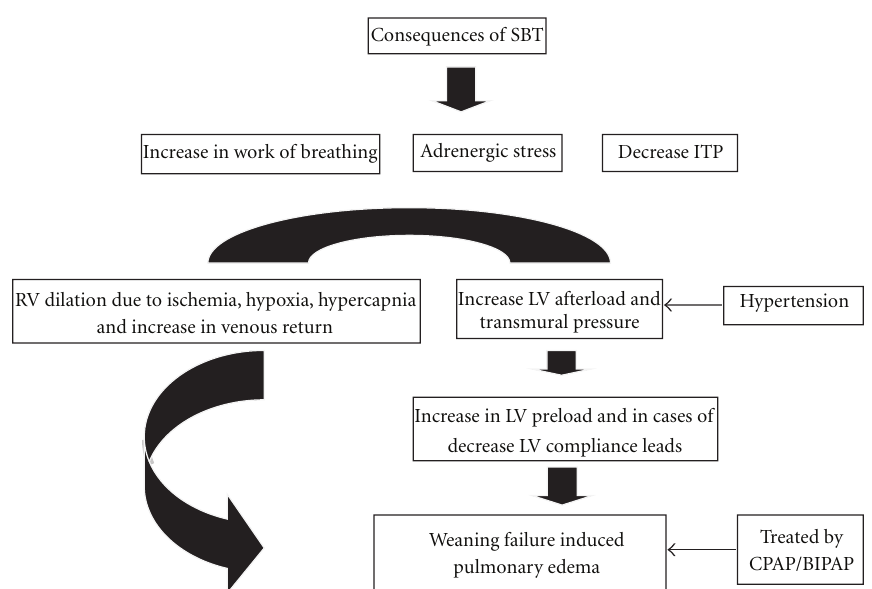
Figure 2: SBT: Spontaneous Breathing Trials, ITP: Intra-thoracic Pressure, CPAP: Continuous Positive Pressure Therapy, BIPAP: Bi-level Positive Pressure, LV: Left Ventricle, RV: Right